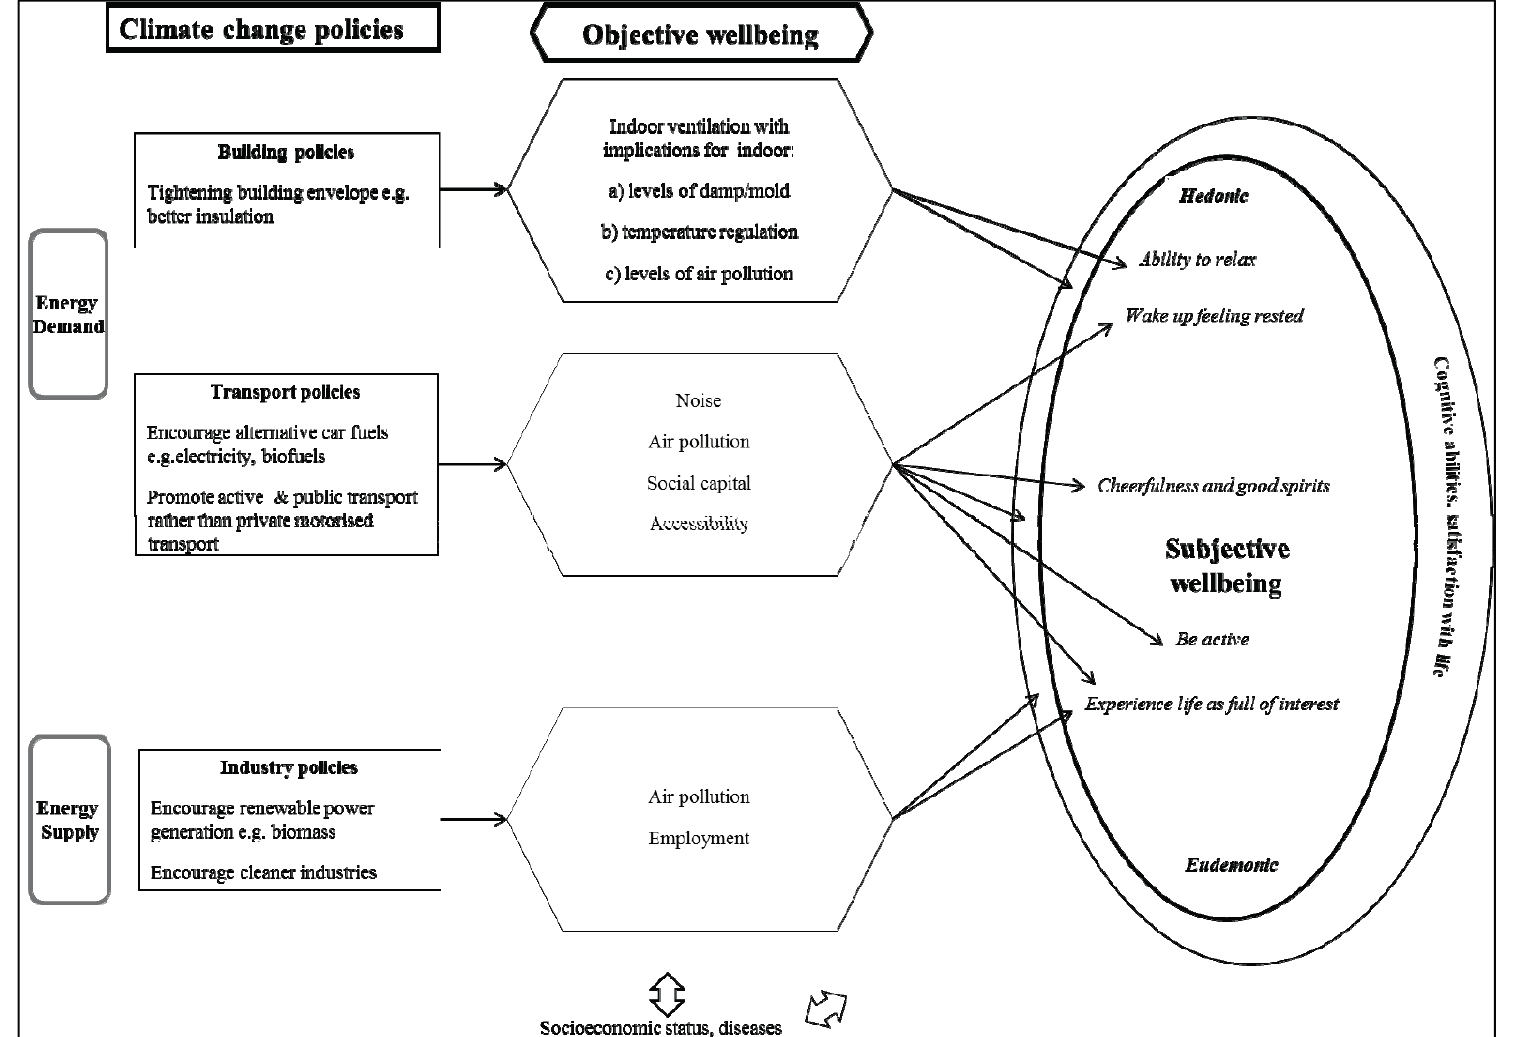
Figure 2. Conceptual model of some example policies to reduce greenhouse gas emissions and